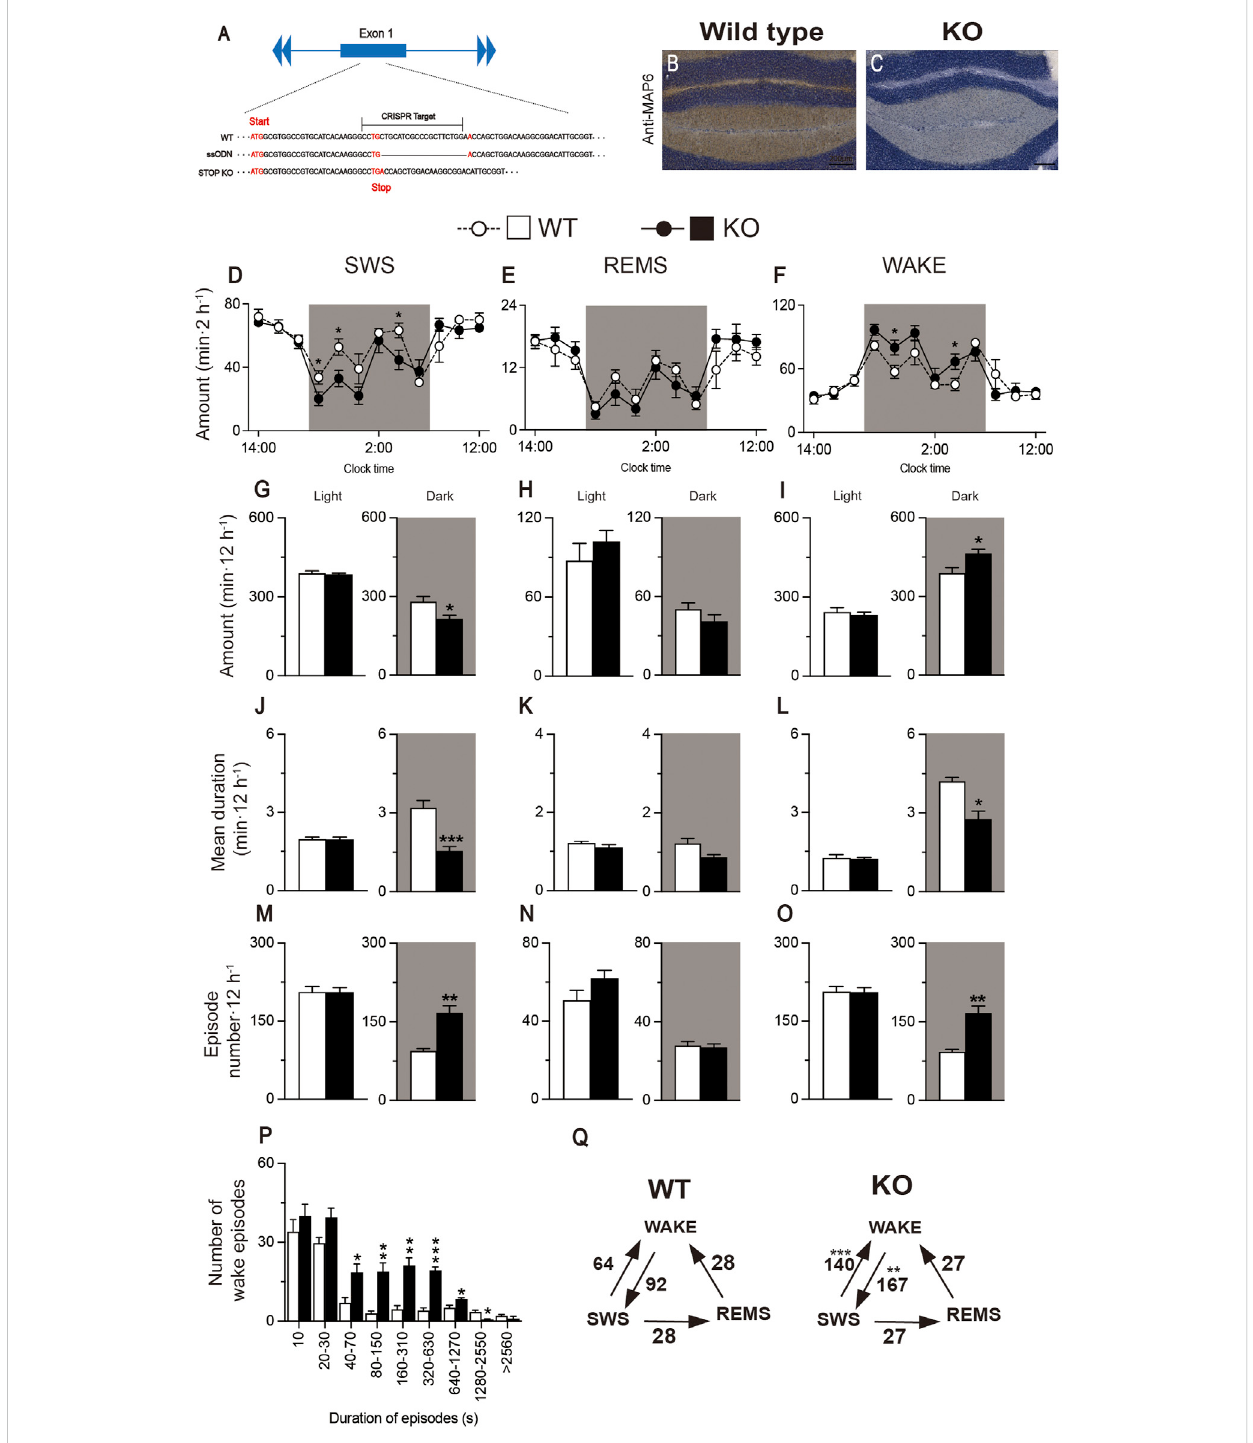
FIGURE 6 Generation of MAP6 (STOP) knockout (KO) mice with increased wakefulness and fragmented sleep and wake phases. (A) Schematic of CRISPR/ Cas9-engineered MAP6 gene knockout (KO) using C57BL/6 mice as fertilized egg donors. The CRISPR target including the PAM sequence (total 23 bp) containspartofexon1oftheMAP6genethatislocated25nucleotidesafterthetranslationstartsite.ssODN,single-strandedoligodeoxynucleotide. (B,C) Histologic veri fi cation of MAP6 KO in the cerebellum of MAP6 (STOP) KO and WT mice. Immunostained MAP6 signals were only detected in wild- type (WT) mice (B) and not in MAP6 (STOP) KO mice (C) . Scale bar, 200 μ m (D – O) Baseline time course (D – F) , total amount (G – I) , mean duration (J – L) , andepisodenumber (M – O) ofSWS,REMS, andwakefulnessduring the12hlightand12hdark (shaded areas)phasesinMAP6 (STOP) KOandWT mice. (P) Wake episode spectrum in MAP6 (STOP) KO and WT mice. (Q) Mean number of transitions between SWS, wake, and REMS. Data (n = 6/group) are presented as mean ± SEM. Signi fi cance levels are indicated as * p < 0.05, ** p < 0.01, and *** p <